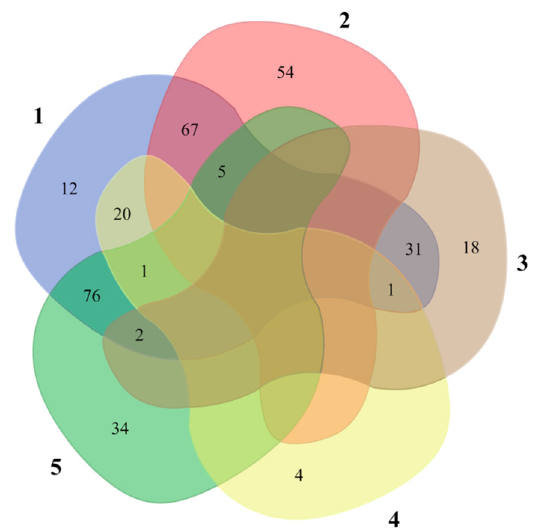
Figure 9. Proteomic analysis of mouse serum. Part 1: Diluted mouse serum; Part 2: Mouse serum treated with poly(NIPAAm- co -DEAEMA- co -tBAAm)-grafted silica column at 10 °C (Group 1); Part 3: Serum treated with poly(NIPAAm- co -AAc- co - t BAAm)-grafted silica column at 50 °C (Group 3); Part 4: Mouse serum treated with poly(NIPAAm- co -DMAEMA- co -VPBA)-grafted silica column at 50 °C (Group 5); Part 5: Mouse serum treated with poly(NIPAAm- co -DMAEMA- co -VPBA)-grafted silica column at 10 °C (Group 6).